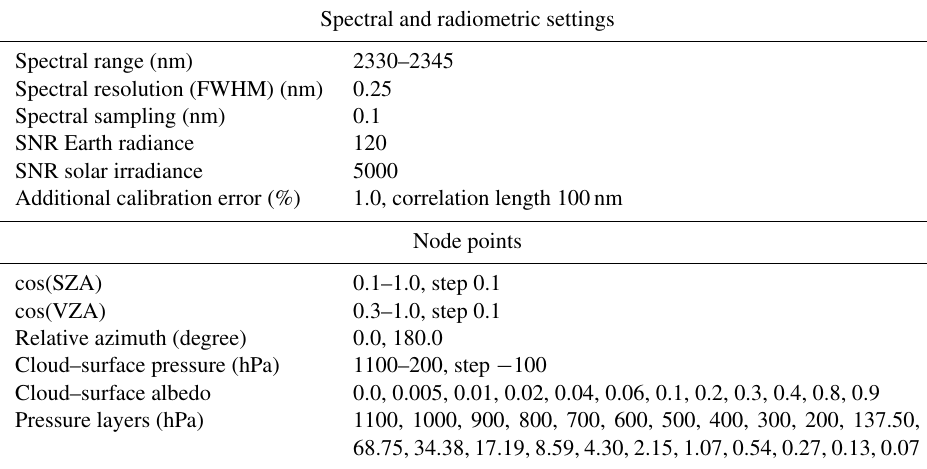
Table 1. Spectral and radiometric settings for DISAMAR and the lookup table node points. Spectral and radiometric